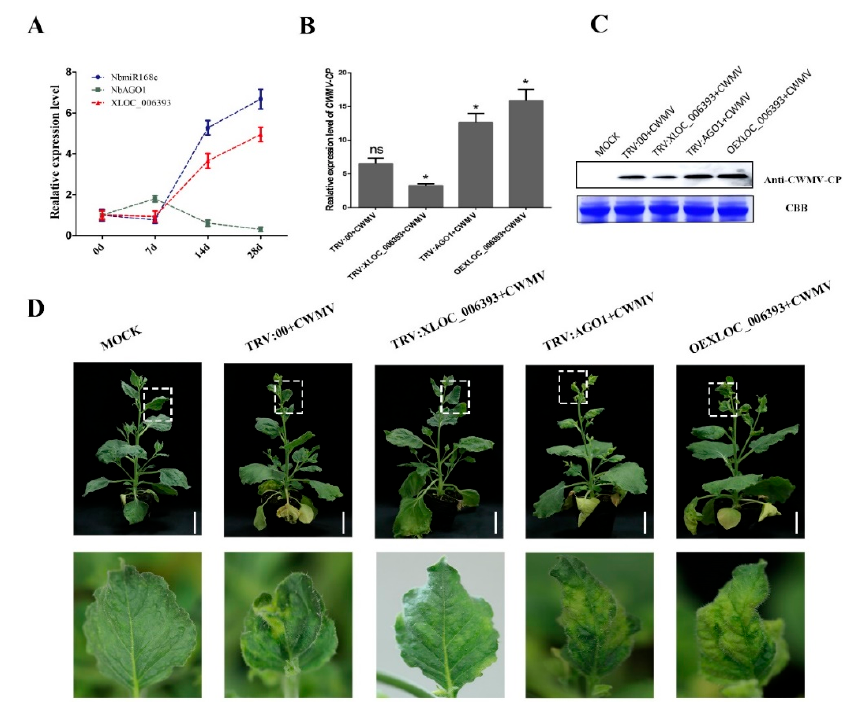
Figure 5. Validation of XLOC_006393 by virus-induced gene silencing. ( A ) The expression levels of XLOC_006393, NbmiR168c , and NbAGO1 were analyzed at different time points (0, 7, 14, and 28 days) after CWMV infection; ( B ) and ( C ) accumulation of CWMV CP was detected in different plant materials, including TRV:NbmiR168c, TRV:NbAGO1, TRV:XLOC_006393, and TRV:00 by qRT ‐ PCR and Western blotting (WB), of which coomassie brilliant blue (CBB) was used to calculate the protein content of different samples—full WB images in Figure S2 and Figure S3. * and ns showed significant and no significant differences between the two samples, respectively; ( D ) mild green mosaic lesions formed successively in the leaves of different plant materials after 30 days of CWMV infection. Bottom photograph is an enlargement of the boxed part of (D). These plant materials contained Mock, TRV:00, TRV:XLOC_006393, TRV:NbAGO1, and OEXLOC_006393.